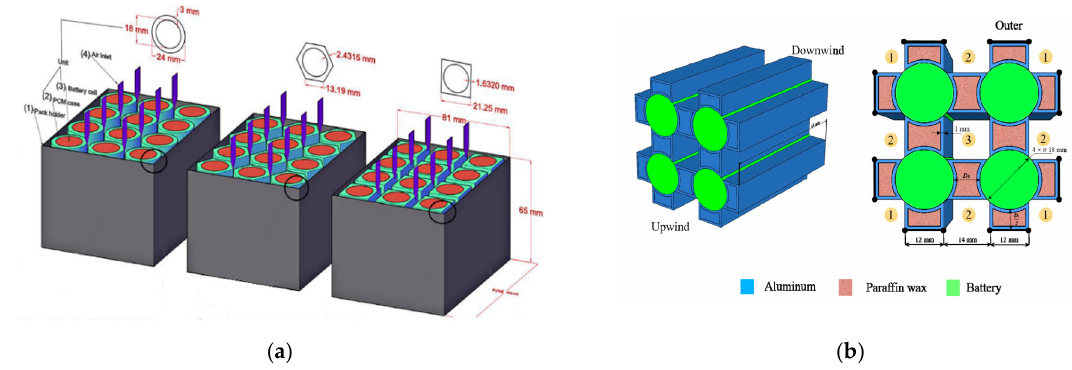
Figure 7. The geometry in PCM-based hybrid BTMS ( a ) Three different shapes of the cross section for PCM-based BTMS Reprint with permission [68]; 2020, Elsevier.; ( b ) Schematic of a PCM-based BTMS. Reprint with permission [69]; 2020, Elsevier.